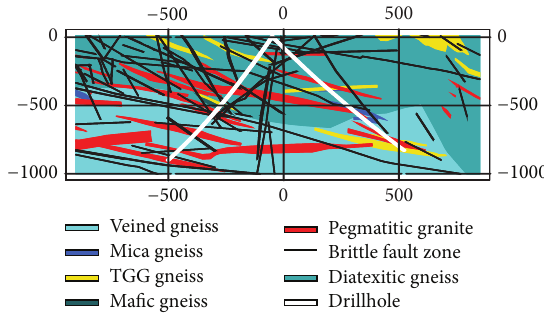
Figure 8: Vertical section of drillholes OL-KR40 (white line on the left) and OL-KR45 (white line on the right). Lithology and brittle fault zones. The azimuth of the section is 98 ∘ clockwise from the north. The section is based on the Geological Model of the Olkiluoto Site, Version 2.0